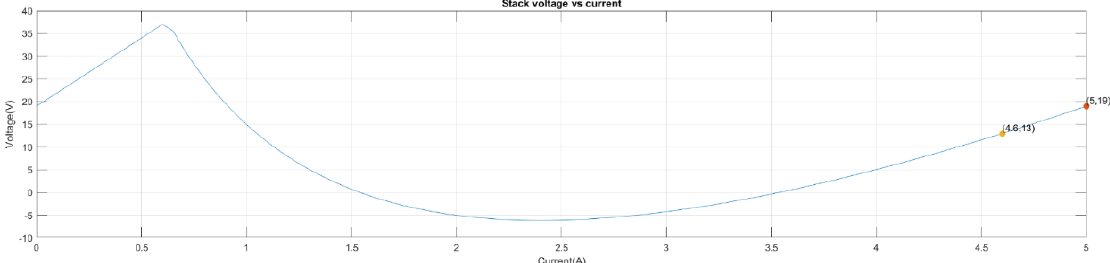
Figure 18. I-V curve simulation of the selected fuel cell.